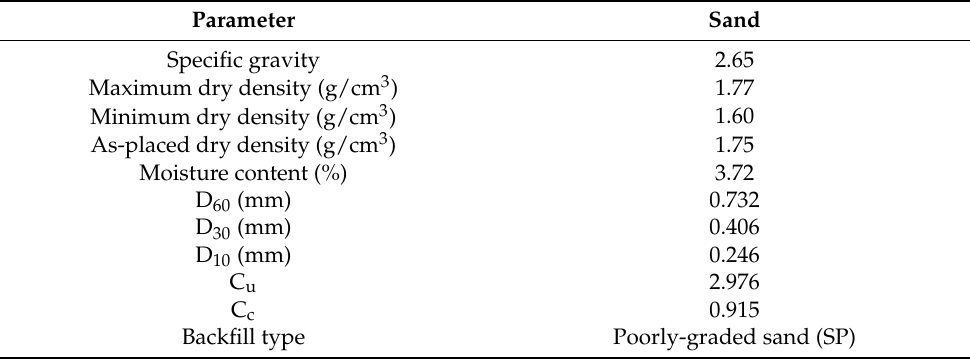
Table 2. Parameters of sand used in